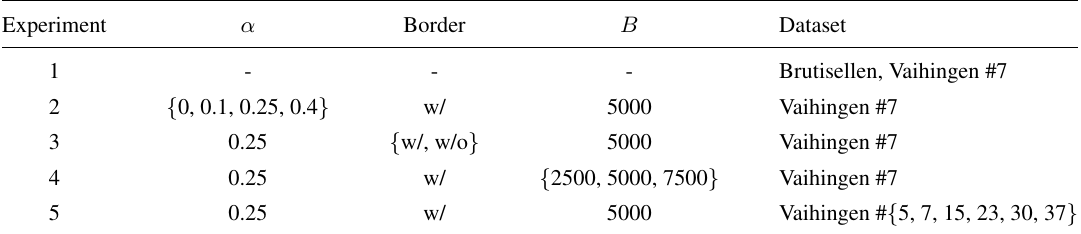
Table 3. Overview of the different parameter variations for the five experiments. Experiments 1-4 were also executed on the other selected areas of the Vaihingen dataset with very similar results. Therefore only area #7 is reported.